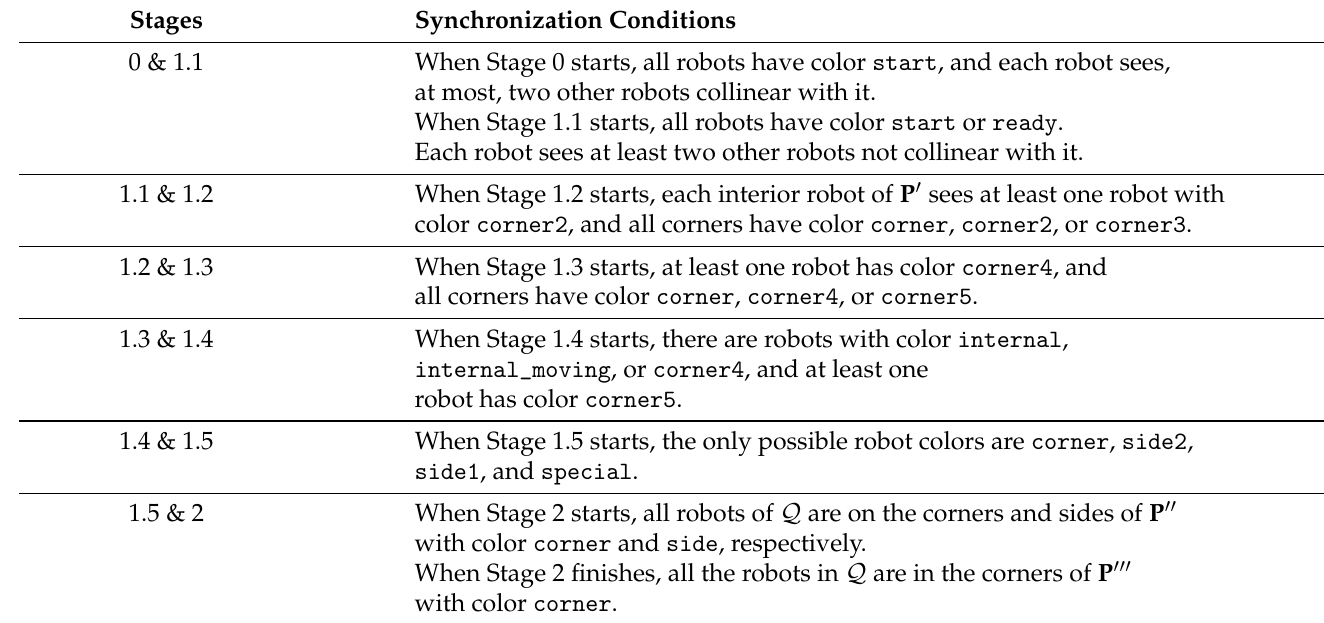
Table 3. An illustration of how the colors of robots synchronize execution of the stages.